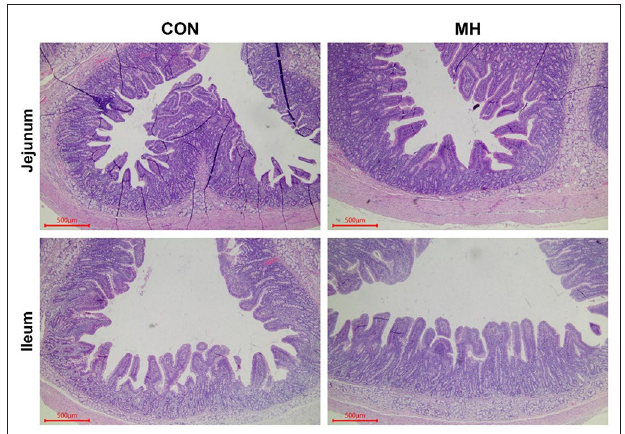
FIGURE 1 | Haematoxylin and eosin (H&E) staining of jejunum and ileum. Note: Scale bar, 500 µ m. CON = basal diet without any additives, MH = basal diet + 8.3 × 10 9 CFU/kg LM1, n = 12 in the CON group, n = 11 in the MH group.